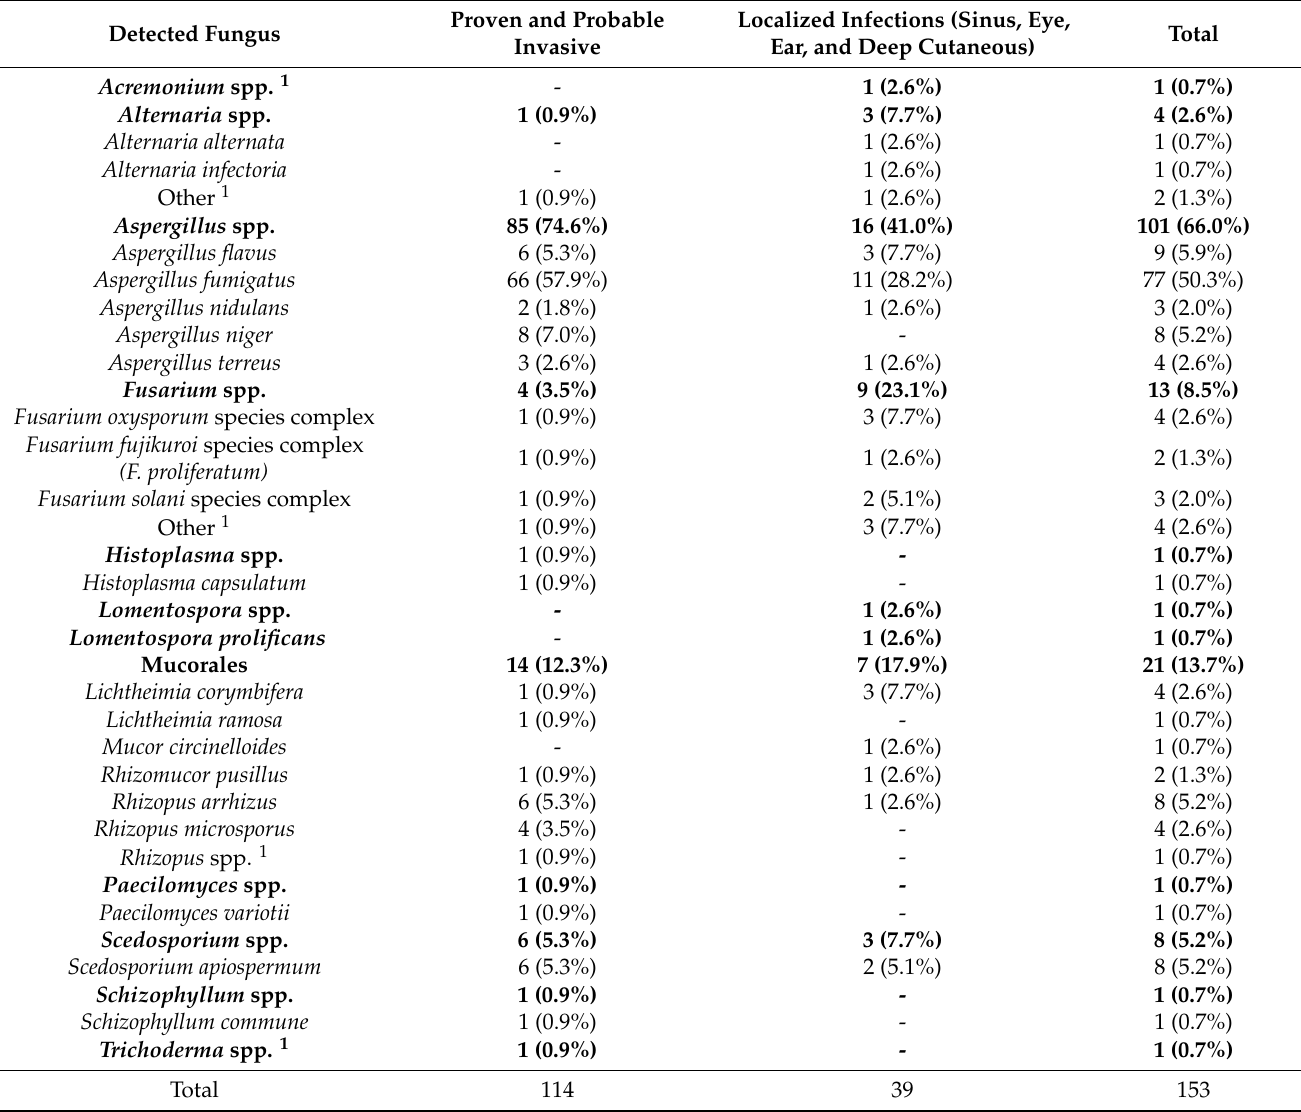
Table 2. Number and species of isolated filamentous